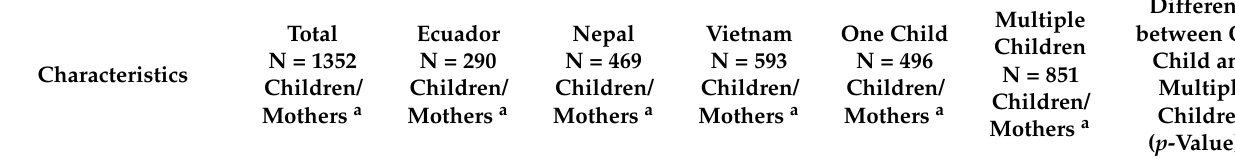
Table 2. Maternal-child oral health and nutrition knowledge and practices a